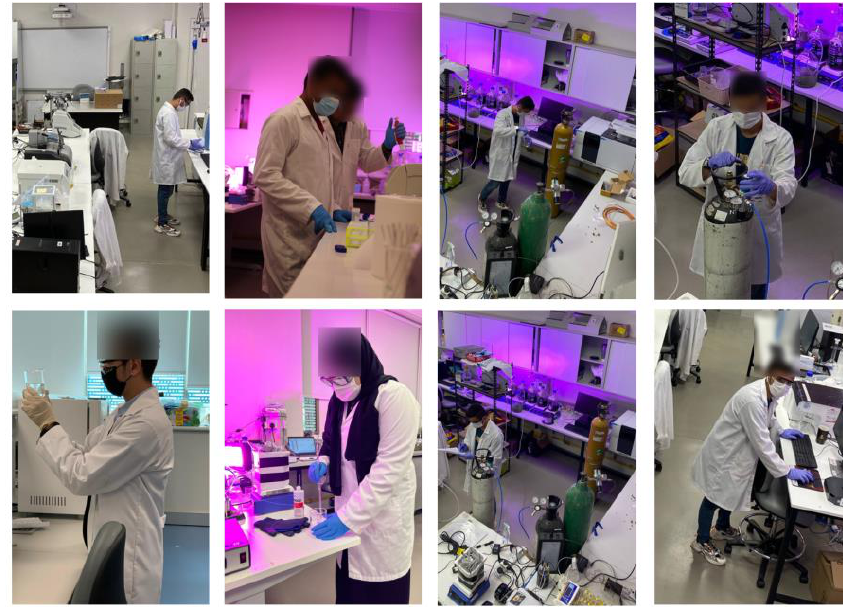
Figure 3. Sample images of Student Laboratory Safety (SLS) dataset.